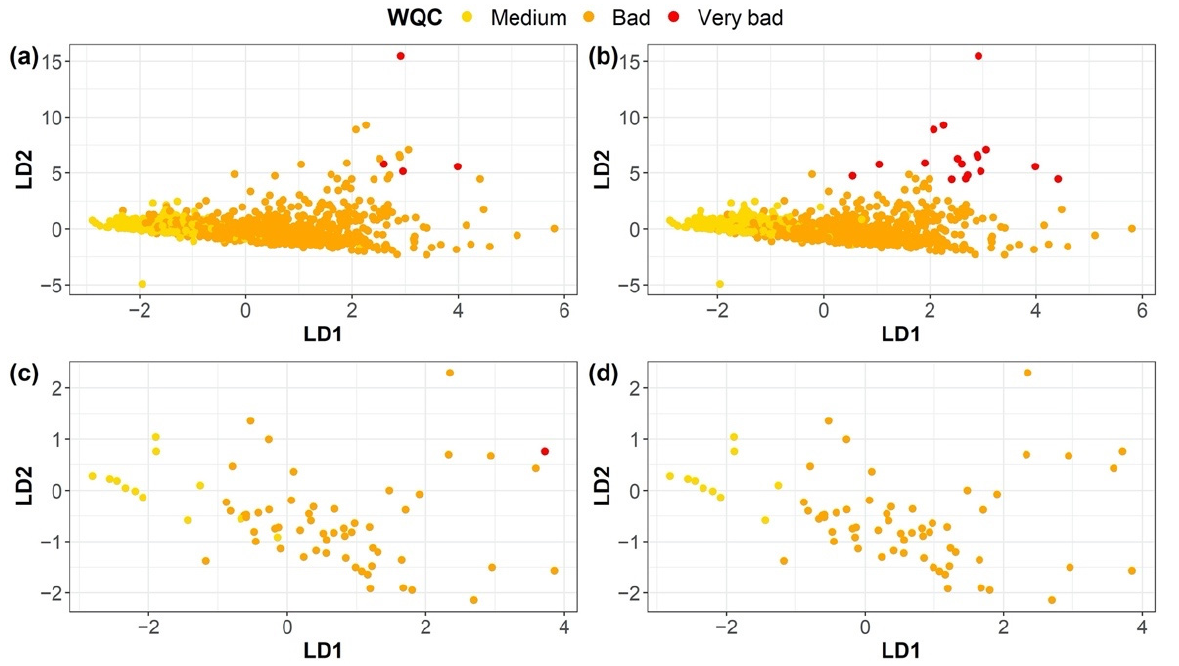
Figure 15. ( a ) Real WQCs obtained by the original WQI calculation algorithm (using the training data subset). ( b ) Predicted WQCs achieved by the model with 12 parameters (using the training data subset). ( c ) Real WQCs obtained by the original WQI calculation algorithm (using the testing data subset). ( d ) Predicted WQCs achieved by the model with 12 parameters (using the testing data subset). Table 6. Summary of discriminant analysis model.